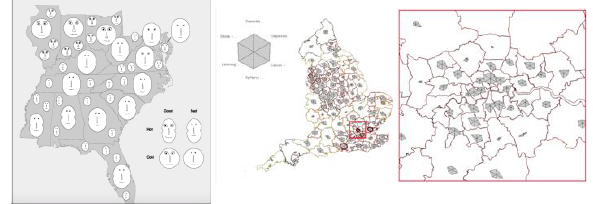
Figure 4. Map Visualizations with Chernoff Faces (left) (Nelson, 2007) and Star Plots (right) (McNabb and Laramee, 2019)